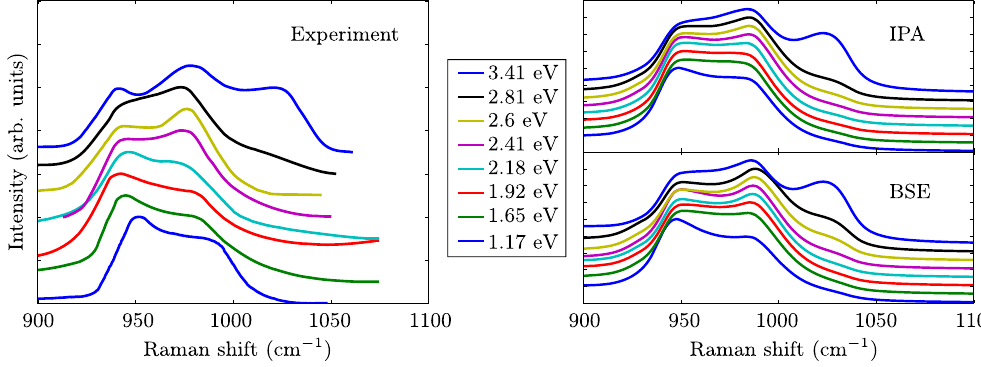
Figure 1. Experimental (left, taken from ref. 26) and theoretical (right) second-order Raman spectra of silicon, between 900 and 1050 cm − 1 , for different excitation energies between 1.17 eV and 3.41 eV, normalized to their maximal values. For clarity, the curves are shifted with respect to each other (lowest excitation energy at the bottom). Theoretical results have been obtained in the independent-particle approximation (IPA) and in the Bethe-Salpeter equation (BSE)